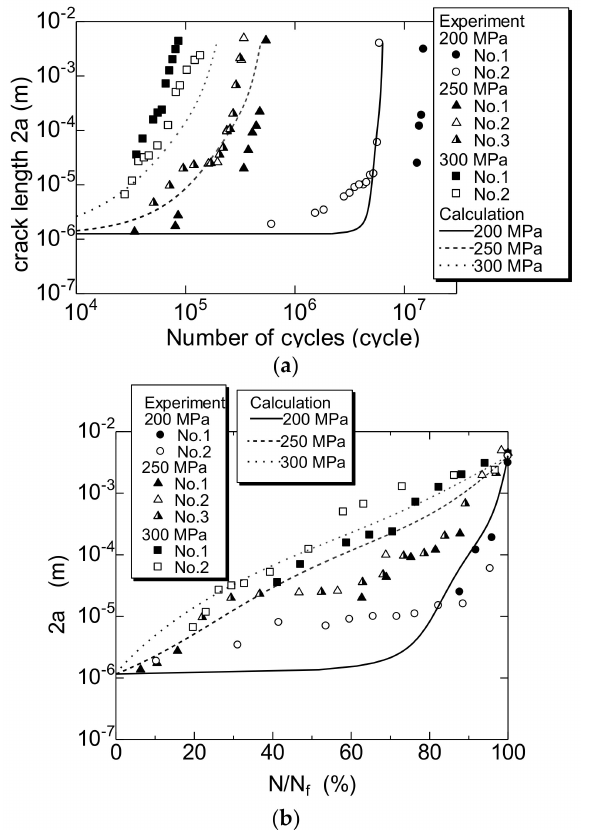
Figure 13. Comparison of the calculation result of the fatigue crack growth curve of the specimen P and the experimental result. ( a ) 2a–N; ( b ) 2a–N/N f .